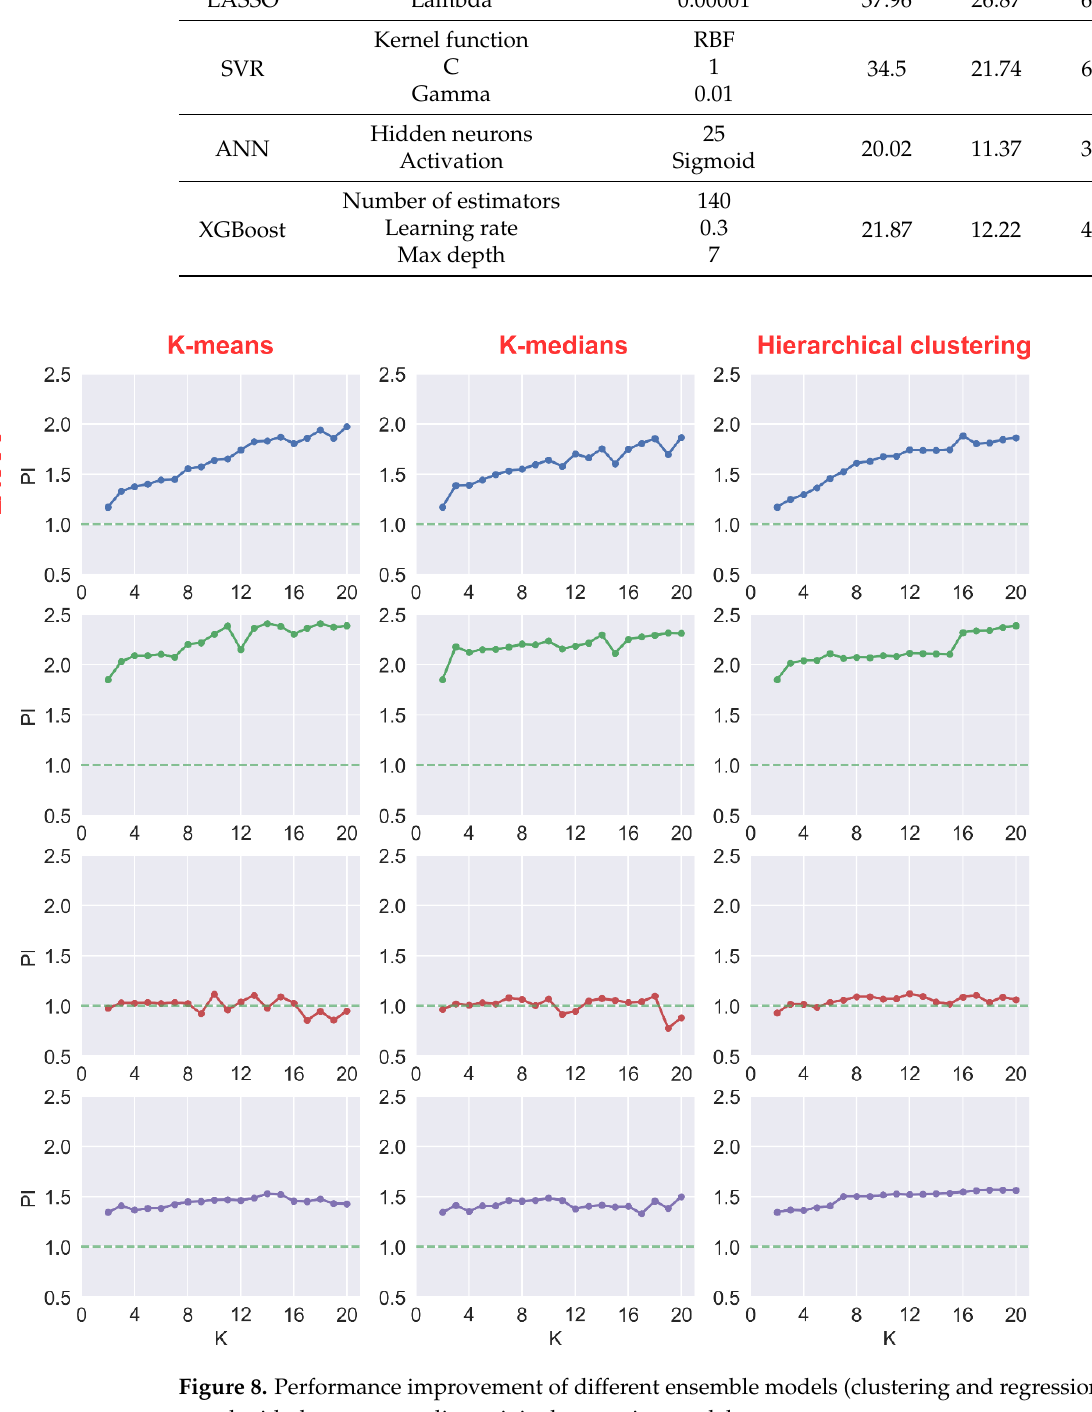
Figure 8. Performance improvement of different ensemble models (clustering and regression) com- pared with the corresponding original regression model.